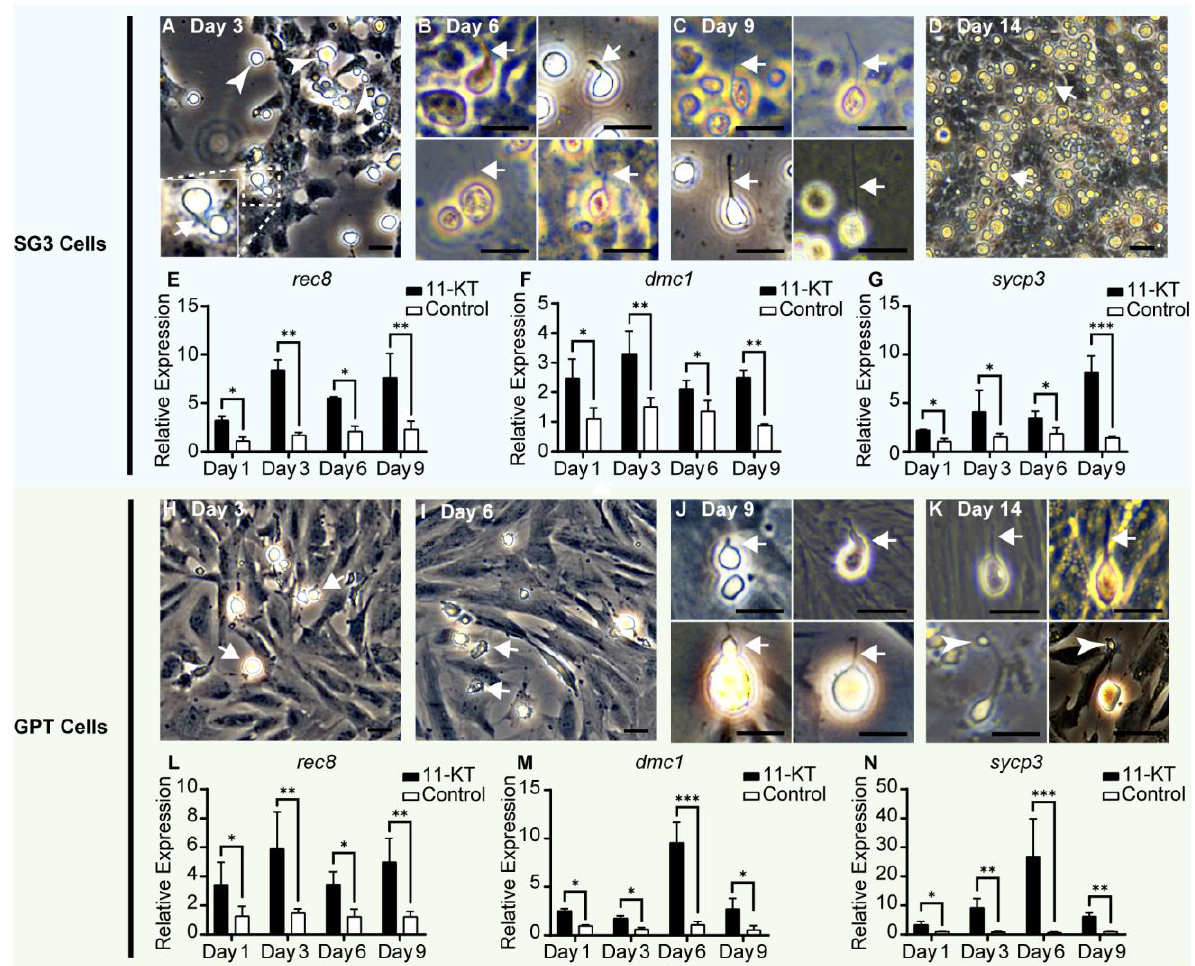
Figure 6. In vitro differentiation of SG3 cells and GPT cells through 11-KT induction. ( A ) SG3 cells produced spherical cells with diverse sizes (Arrowheads) and a few spherical cells with a short protrusion (Arrows) after 3 days of induction. ( B ) A few spherical cells further elongated their tails like the sperm (Arrows) after 6 days of induction. ( C ) About 9 days, a few sperm-like cells had a long tail (Arrows). ( D ) SG3 cells produced a large number of spherical cells and a few sperm-like cells with a tail (Arrows) about 14 days of treatment. ( E – G ) The expressions of meiotic marker genes rec8 , dmc1 , and sycp3 in SG3 cells were significantly promoted by 11-KT induction. With the elongation of 11-KT induction time, the expression level of genes, except sycp3 , did not show an increasing trend. The data were shown as the mean ± SEM of three samples and the values with asterisks were significantly different (* p < 0.05, ** p < 0.01, and *** p < 0.001). Statistical analysis was performed by